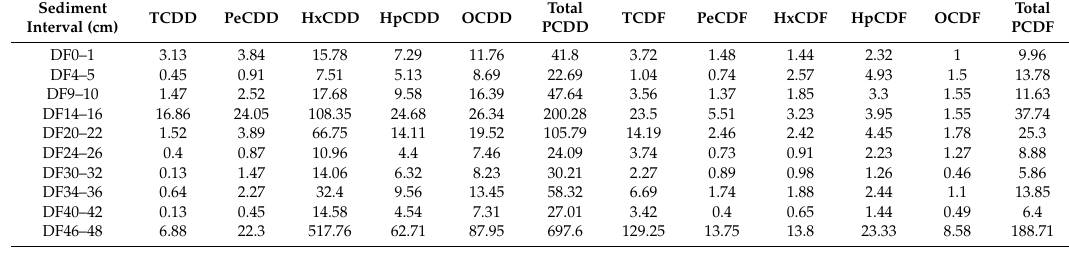
Figure 6. Downcore variation in Total Polychlorinated Dibenzo ‐ p ‐ dioxin (PCDD; A ) and Total Polychlorinated Dibenzo ‐ p ‐ furan (PCDF; B ) for bulk sediment samples. Table 4. Homologue and total homologue (PCDD, PCDF) concentration (pg / g) for dioxins and furans in bulk sediment samples from selected depth intervals.